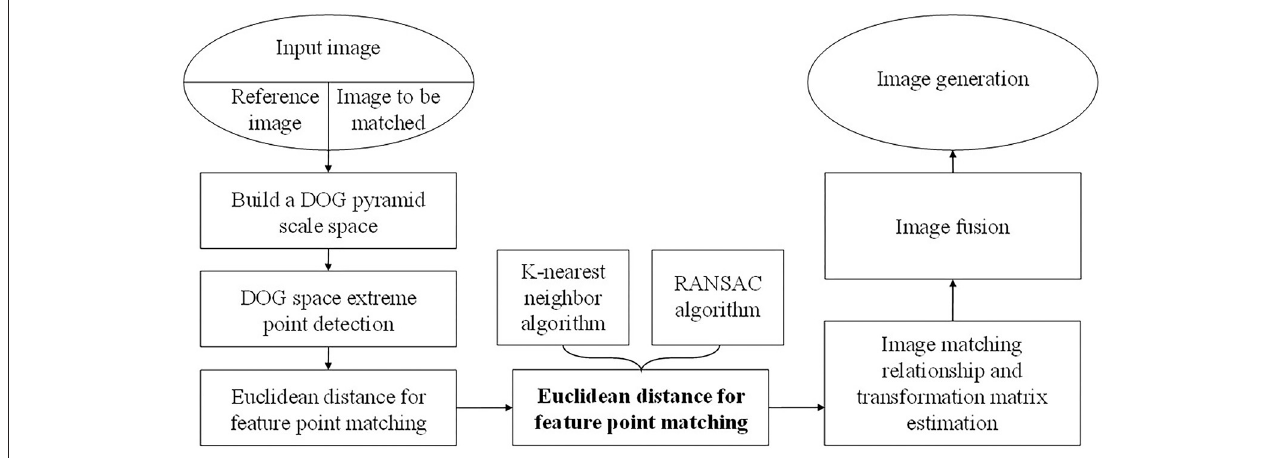
FIGURE 1 | Flow chart of improved SIFT